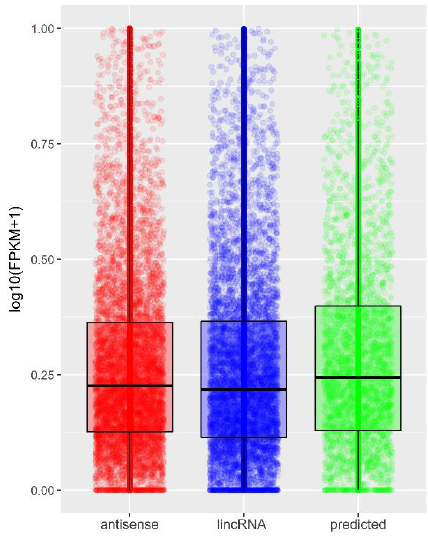
Figure 4. Dispersion of normalized FPKM values presented for the two most numerous lncRNA biotypes: antisense (red), lincRNA (blue), and transcripts predicted as lncRNA (green). Each point represents an individual transcript.